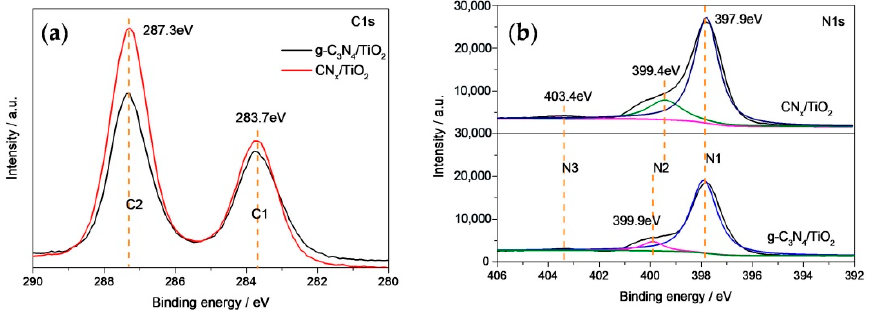
Figure 4. XPS spectra of ( a ) C1s and ( b ) N1s peaks of g-C 3 N 4 /TiO 2 and CN x /TiO 2 core-shell nanowire arrays.